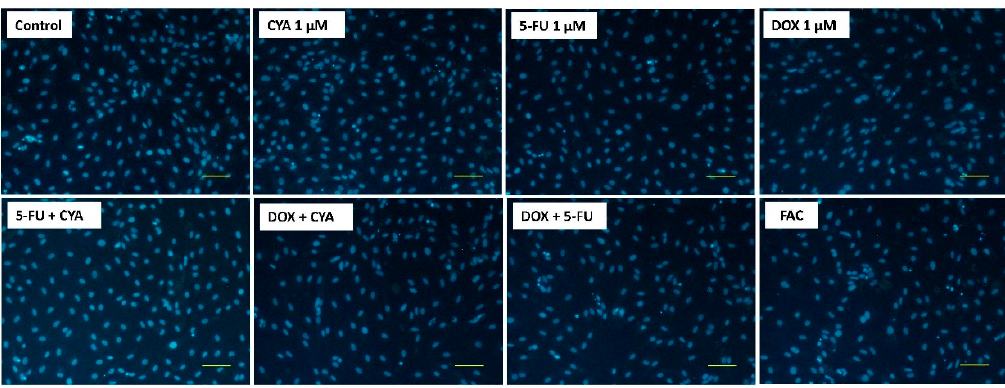
Figure 6. Fluorescence microscopy (Hoechst 33258 staining) of differentiated H9c2 cells after a 48-h incubation with 1 μ M of FAC, other mixtures of DOX, 5-FU and CYA and the drugs alone. Images are representative of two independent experiments (scale bar 100 μ m).